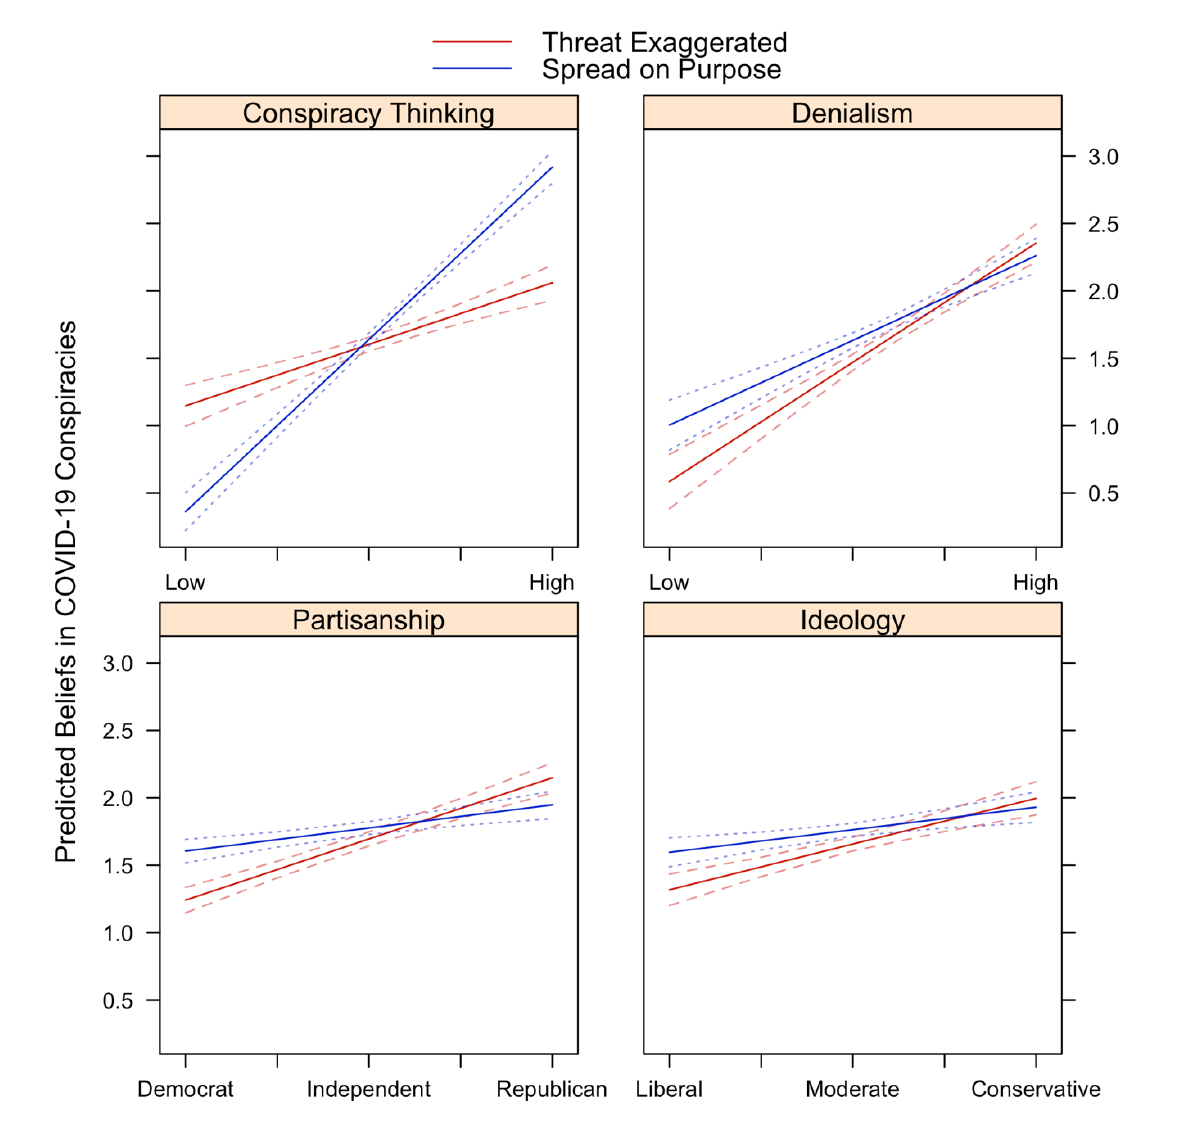
Figure 3. Predicted effects of conspiracy thinking, denialism, partisanship, and ideolog y. Other variables from the models presented in Figure 2 are held constant at their mean in generating